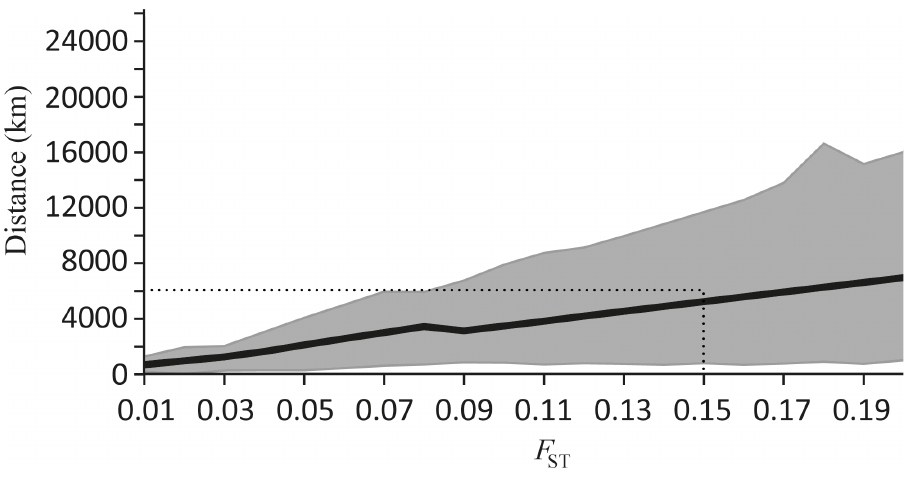
Fig 7. Geographic distances (km) expected between populations of marine fish with increasing F ST based on meta-analysis data. The black line represents the median distance expected for an F ST value and is presented in relation to the 95% confidence intervals (grey dotted line) (S7 Table). An F ST of 0.15 has been marked on the graph as it generally is considered to be significant